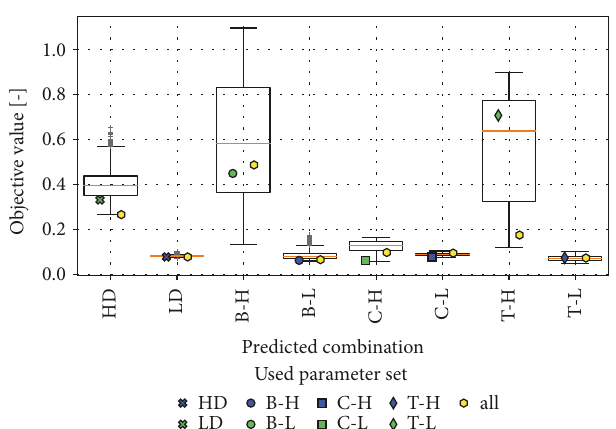
Figure 9: The distribution of the objective values per density level combination is displayed by the boxplots. The markers indicate, per used parameter set, how much the objective value would deviate from its optimum if the optimal parameter set, obtained using the same (combination of) movement base case(s) but a different density level, would be used. The combinations are identified by their acronyms as found in Table